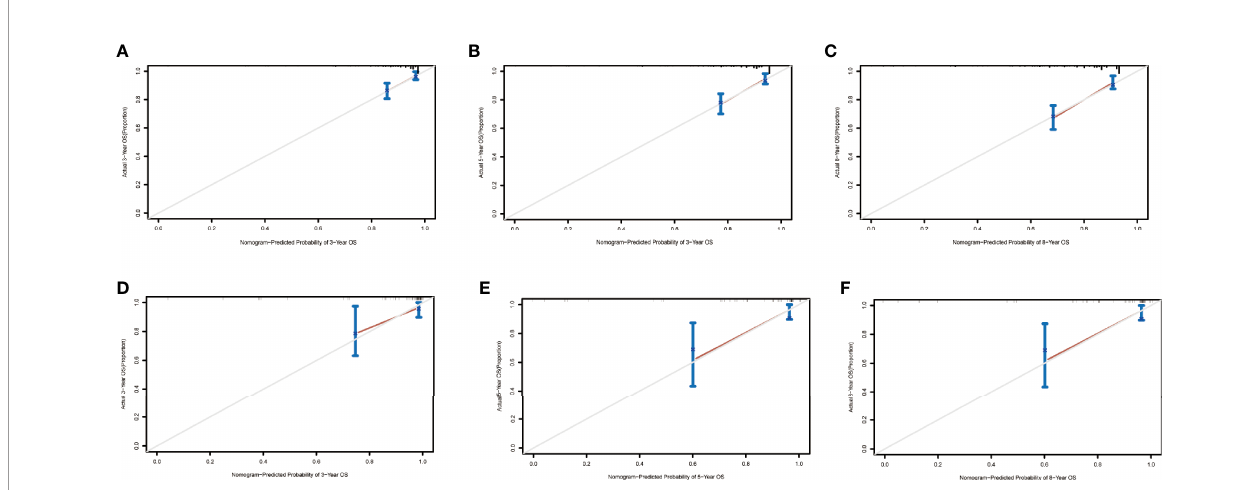
FIGURE 5 | Calibration curves at 3, 5, and 8 years in the training set for validating the overall survival (OS) prediction nomogram (A – C) . Calibration curves at 3 and 5 years in the validation set for the OS prediction nomogram (D – F) .